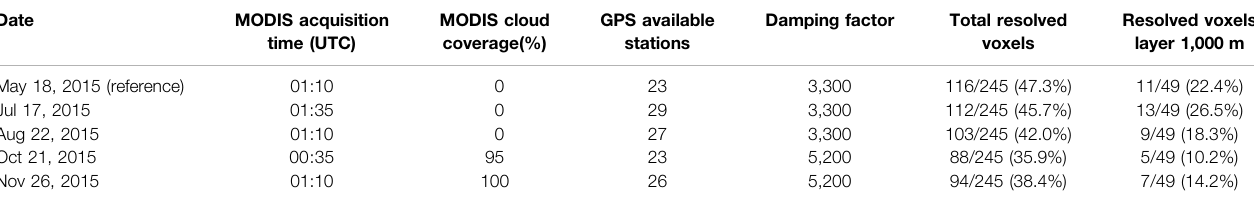
Frontiers in Earth Science |